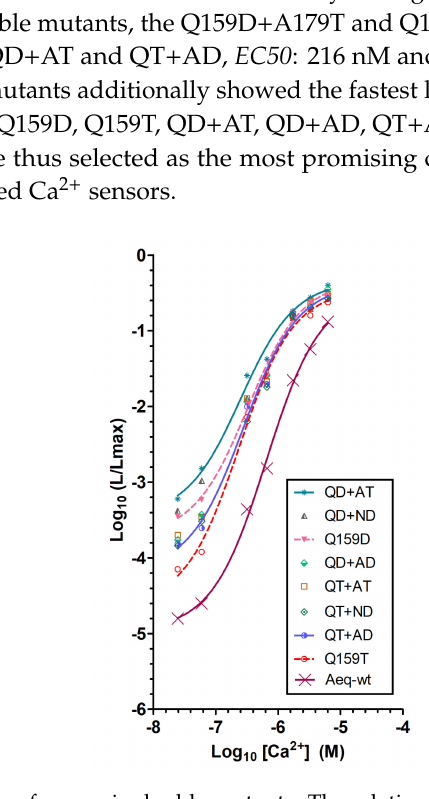
Figure 3. Ca 2 + sensitivity of aequorin double mutants. The relationship between Ca 2 + concentration ([Ca 2 + ]) and fractional bioluminescence intensity (L / Lmax) is displayed in Log values on a linear scale. Aequorin reconstitution was with CLZ-f. The graph shows Ca 2 + sensitivity of aequorin double mutants combining single mutations that resulted in Ca 2 + extra-sensitivity (AequorinXS), n was at least 4. For wt-aequorin, a sigmoidal curve fit is traced for comparison. R square of the fit goodness was higher than 0.994. The following abbreviations are used for clarity: QD + AT (Q159D + A179T), QD + ND (Q159D + N121D), QD + AD (Q159D + A123D), QT + AT (Q159T + A179T), QT + ND (Q159T + N121D), QT + AD (Q159T +